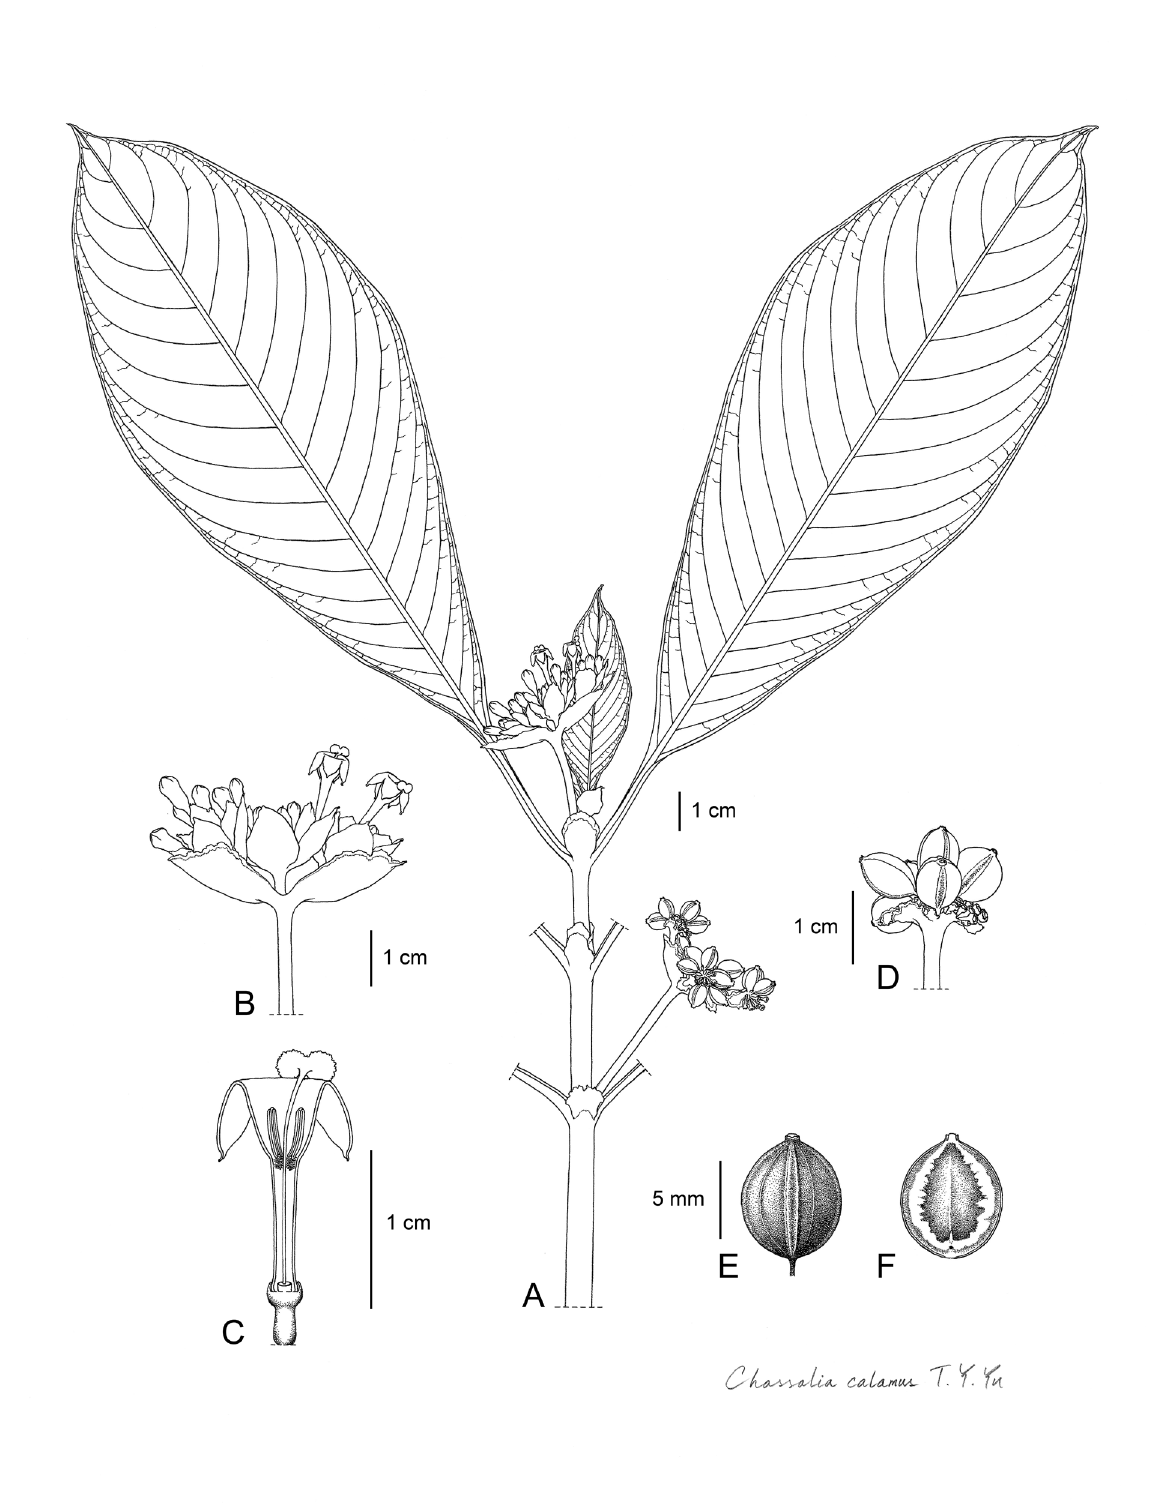
Fig. 8. Chassalia calamus T.Y.Yu sp. nov. A . Flowering shoot. B . Inflorescence. C . Longitudinal view of flower showing stamens, band of hairs, stigma, style, disc, calyx and hypanthium. D . Part of infructescence. E . Dry fruit. F . Pyrene ventral surface. From Asik Mantor SAN 118683 . Drawn by T.Y.